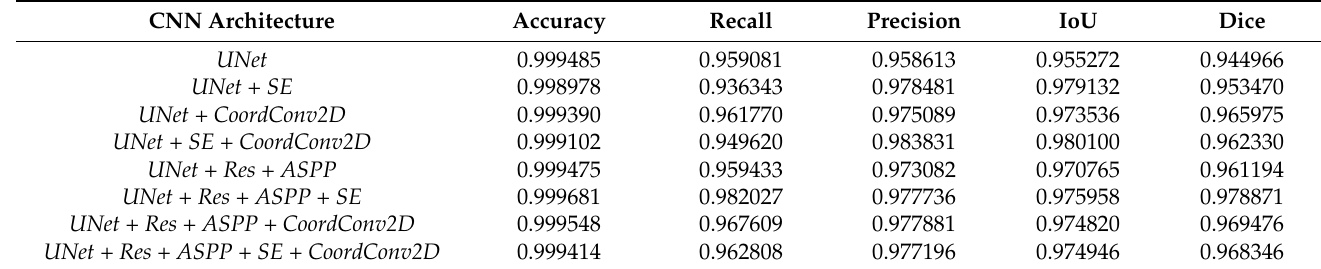
Table 4. Each model’s best-performing weights results.